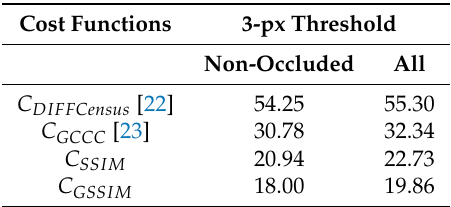
Table 1. Percentage of erroneous disparities of stereo matching without an aggregation method for KITTI 2012 training database.